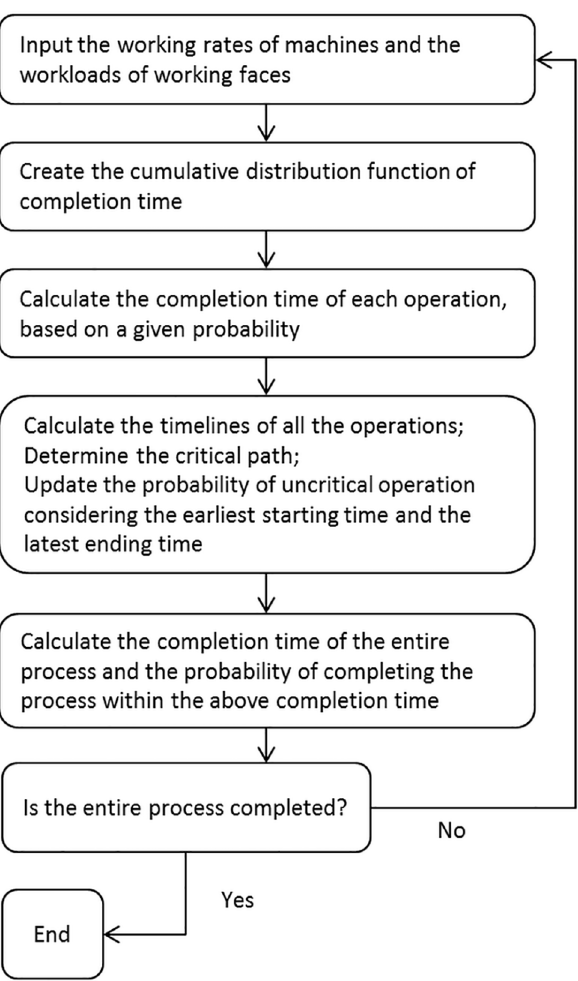
Fig 6. Flow chart of the new algorithm developed based on